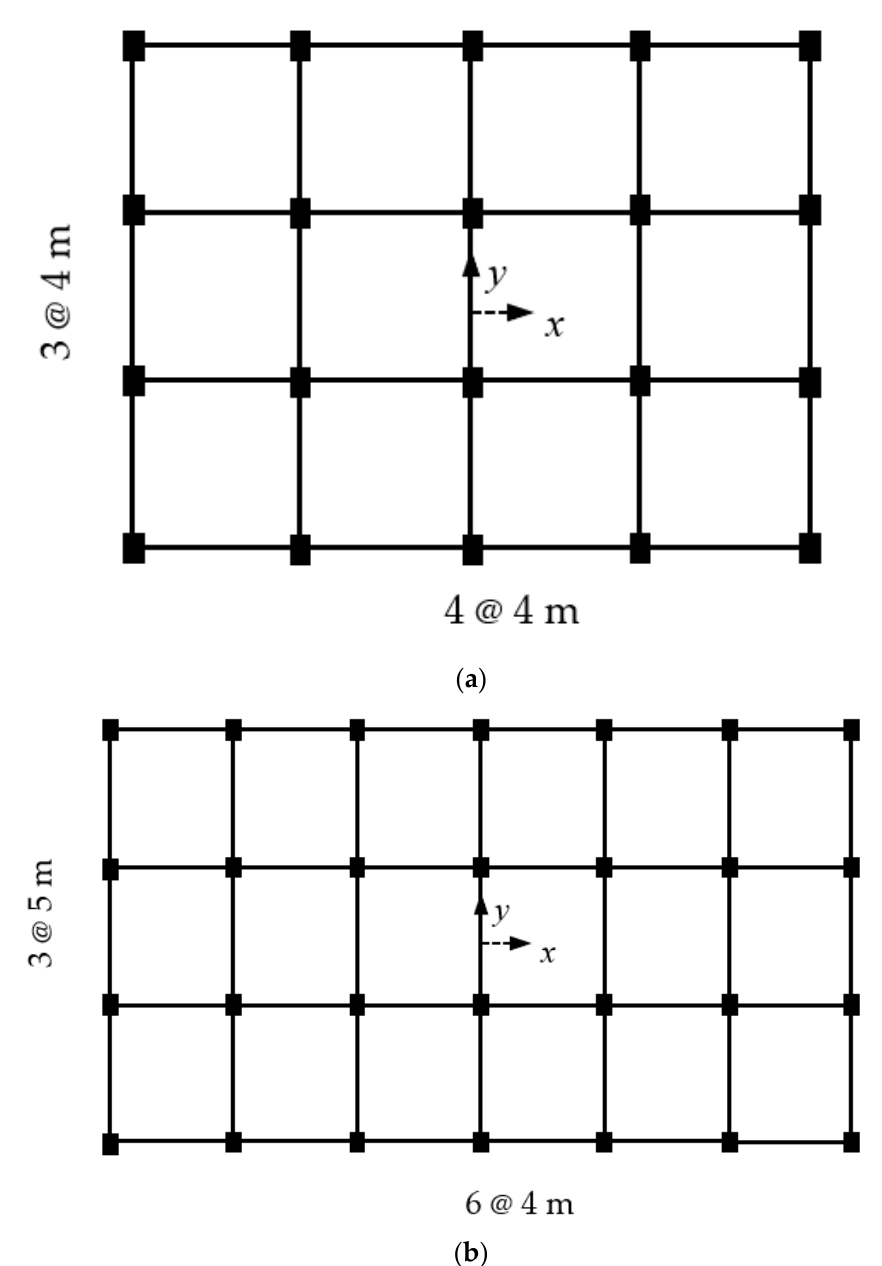
Figure 1. Building plans considered in the study ( a ) Plan I ( b ) Plan II.